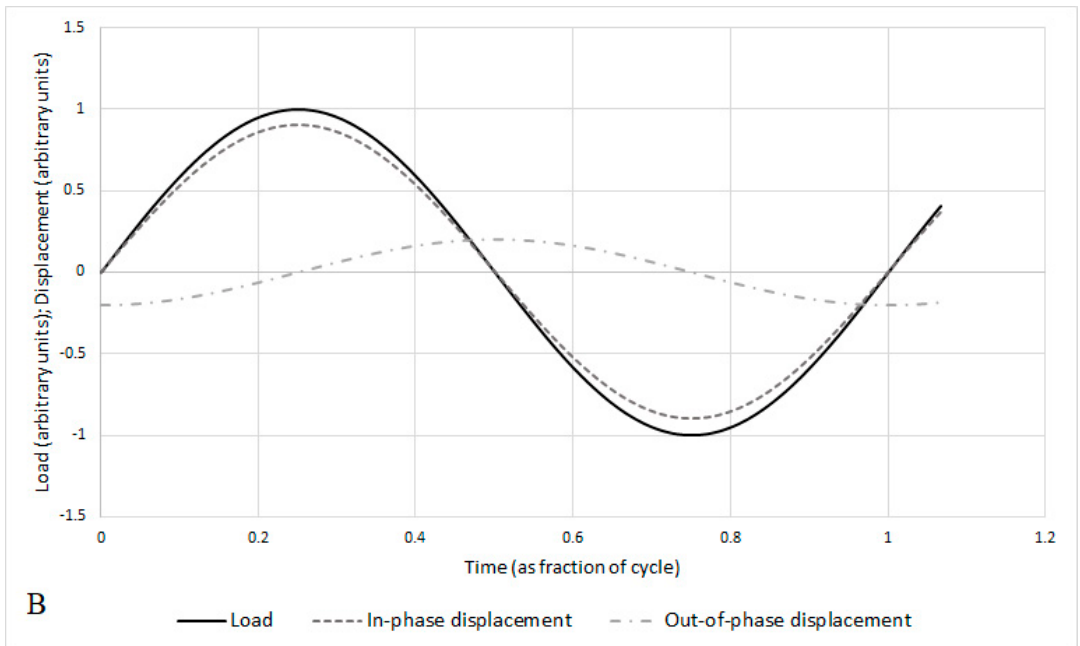
Figure 1. Behaviour of a viscoelastic material under sinusoidally varying load: ( A ) displacement lags behind the applied load by time ∆ t, ( B ) Displacement can be resolved into in-phase and out-of-phase responses.